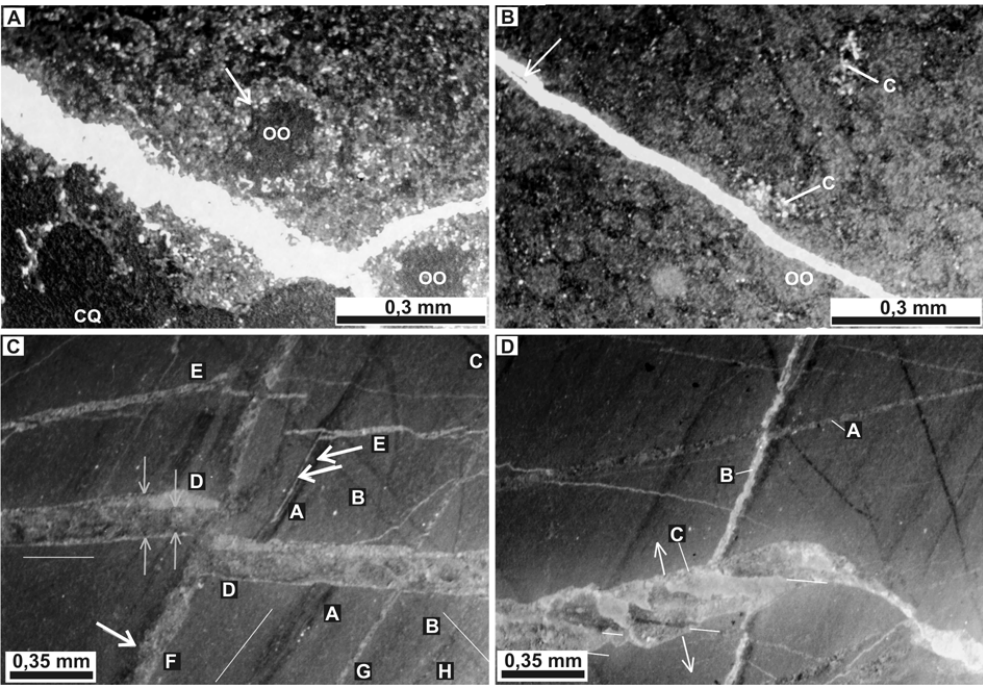
Fig. 6 – Cathodoluminescence. A – Carbonate grains (OO) and cement are strongly silicified (CQ), a big fracture is observed (Mn calcite filling). The arrow points to the later replacement of the quartz cement by calcite. B – Another sector of the same thin section of A. Light areas to the right are carbonate grains (OO), the quartz cement that rims the grains is more intense to the left of the picture. The fracture is Mn calcite, but it has a relict of the previous non luminescent filling (arrow). Later pulses of Mn calcite are replacing the micro-quartz (C). C–D: Different stages of fracturing in the same thin